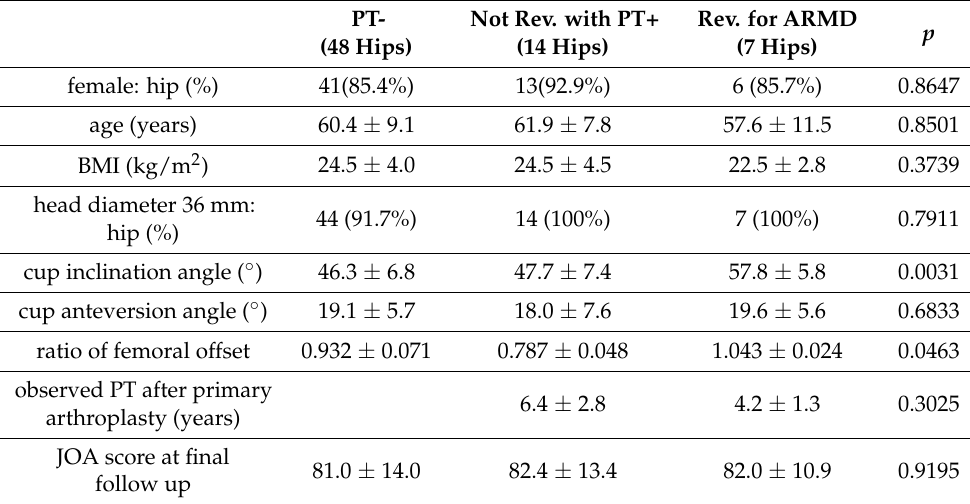
follow up The mean ( ± SD) preoperative JOA hip score of 46.0 ( ± 11.6) improved significantly to 82.2 ( ± 12.7) postoperatively at the final follow-up ( n = 62 hips, excluding 8 revision cases) (Figure 3). No significant differences in JOA hip scores (mean ± SD) were observed between patients without PTs (81.0 ± 14.0), those with PTs but no revision (82.4 ± 13.4), and those treated with revision THA for ARMD (82.0 ±